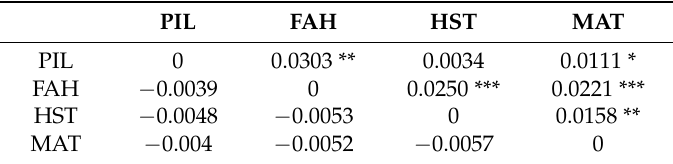
Table 1. Pairwise F ST values between sampling sites based on neutral genetic markers (2208 SNPs, below the diagonal) and non-neutral genetic markers (linked loci + candidate outliers, above